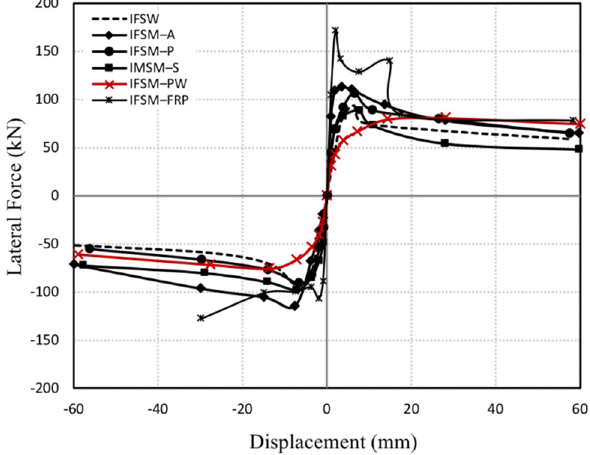
Figure 8. Skeleton curves of specimens.